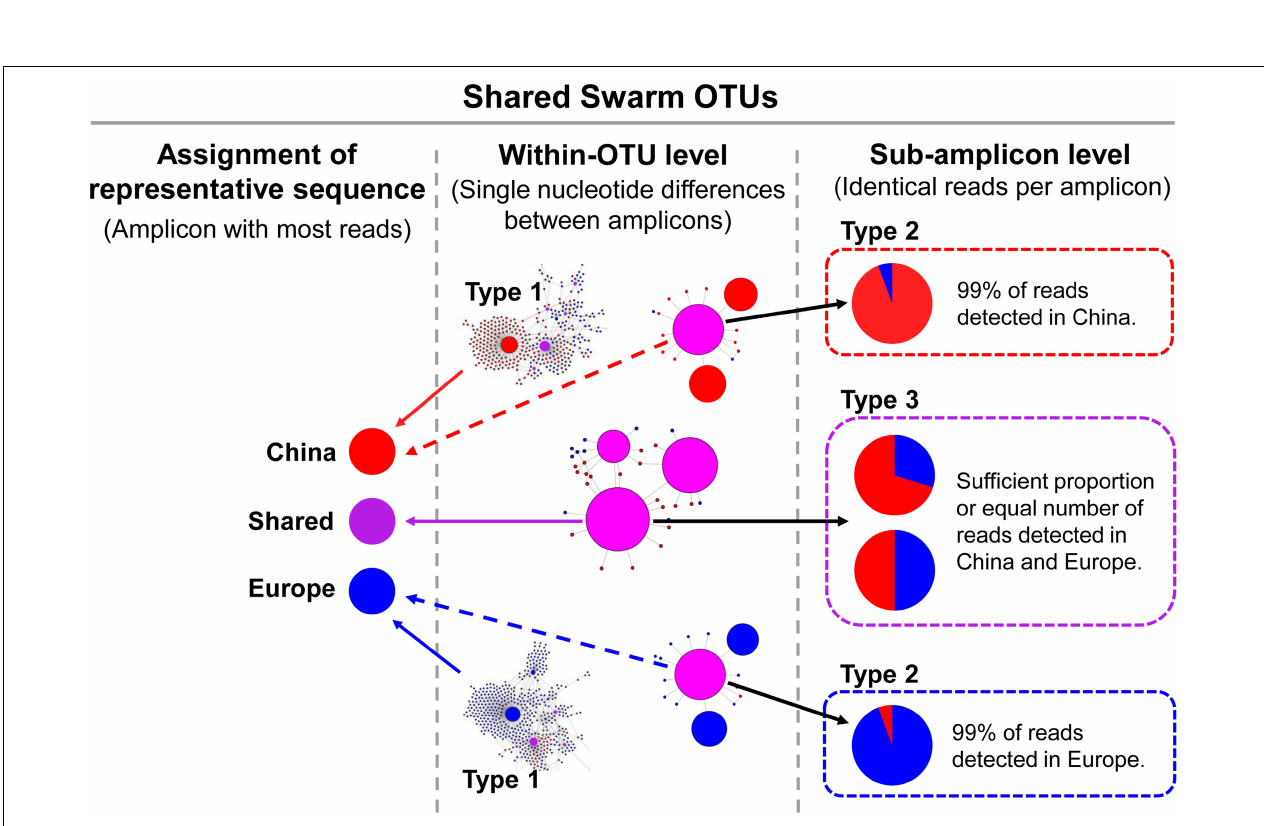
FIGURE 2 | Types of shared Swarm OTUs. The circle sizes in the within-OTU networks correspond to the read numbers of the respective amplicons. The representative amplicons (with highest read number) of the shared OTUs might comprise reads from China and Europe in different proportions. In Type 1 of shared OTUs, the representative amplicon consists of reads only detected in China or in Europe. In Type 2 of shared OTUs, only a minute proportion of reads was detected in the respective other region and is attributed to methodological artifacts (sample bleeding; Mitra et al., 2015). Accordingly, Type 2 of shared OTUs is interpreted as purely consisting of reads from the dominating region. In Type 3 of shared OTUs, similar read numbers from China and Europe constitute the representative amplicon.